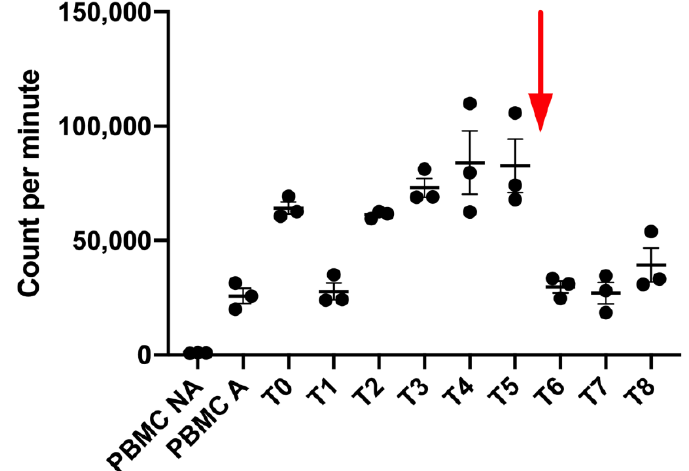
Figure 8. Patient’s Exosomes effect on regulation of activated PBMC (PHA 1µg/mL). Activated PBMC only (PBMC A) use as positive control and non-activated PBMC (PBMC NA) as negative control. The red arrow represent time of the single dose injection of Nivolumab.